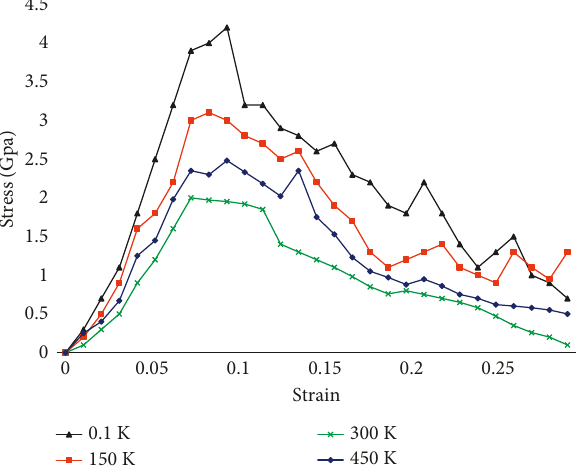
Figure 7: Carbon nanotube stress at different